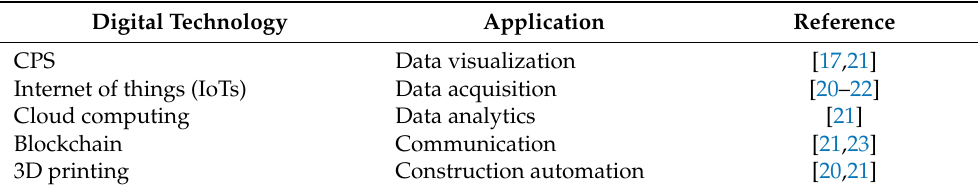
Table 1. The potential digital technologies adopted in the construction